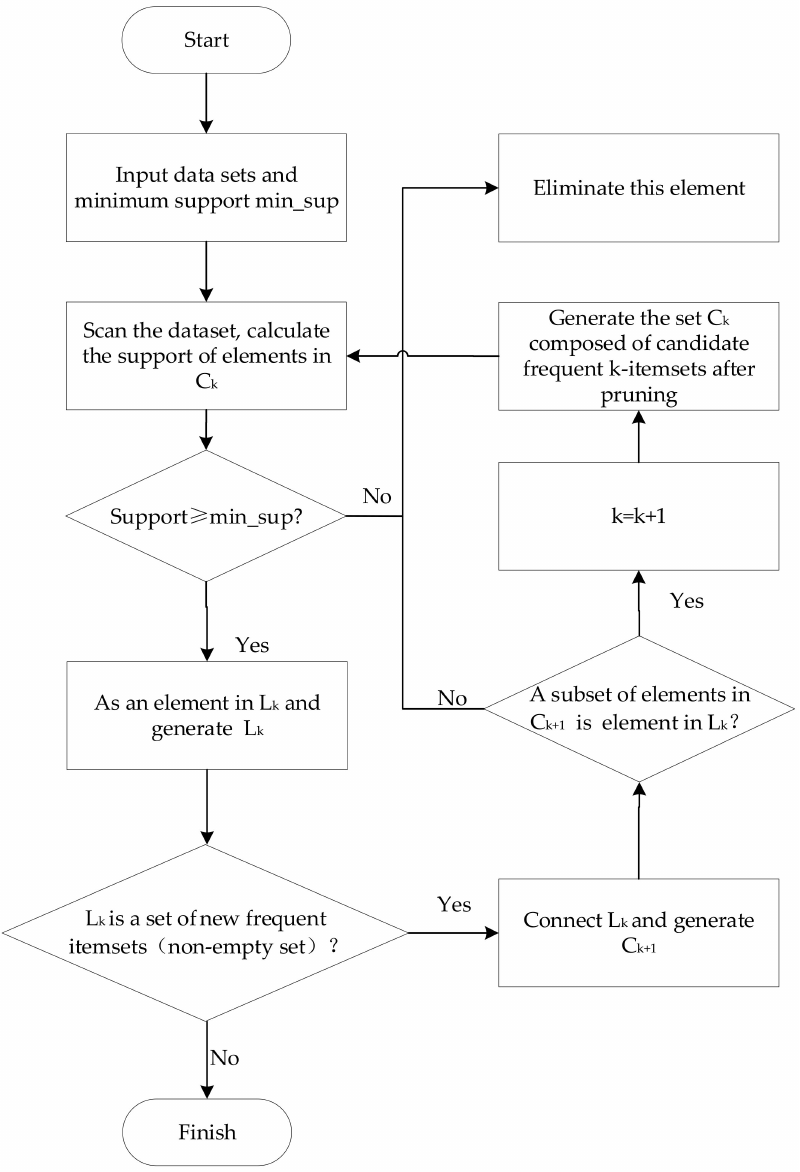
Figure 4. Implementation process of mining all frequent itemsets using Apriori